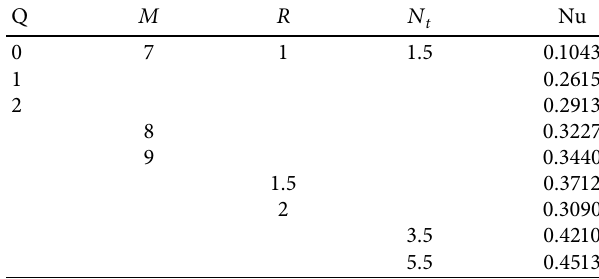
Table 6: The impact of Q, R,N O 2 3 Reynold, thermophoresis parameter, and magnetic field parameter) on Nusselt number of the flow problem.